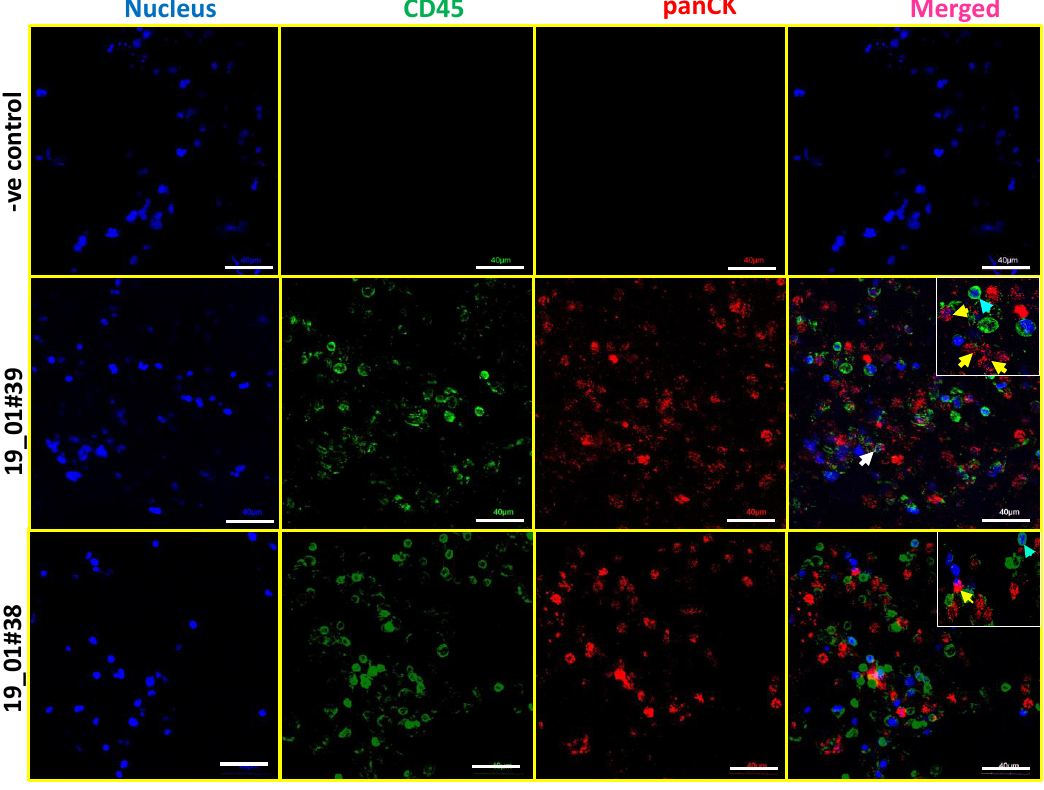
Figure 3. Identification of CK-positive and CD45-negative CTCs in breast cancer patient blood samples cultured in 3D PCL sca ff old. Immunostaining shows the presence of panCK +/ CD45 − CTCs in day 14 cultures of patient blood samples cultured in 3D PCL sca ff olds. Top panel shows negative control (minus primary antibody). Middle and bottom panels show immunostaining done on two di ff erent patient samples. Yellow arrows indicate panCK + and CD45 negative CTCs while blue arrows indicate CD45 positive leucocyte lineage cells. White arrow shows CK + cells surrounded by CD45 + cells. Imaging was performed using confocal microscope, and maximum intensity projections are shown. Inset shows higher magnification. Scale bar represents 40 µ m. Images are representative of 7 independent patient